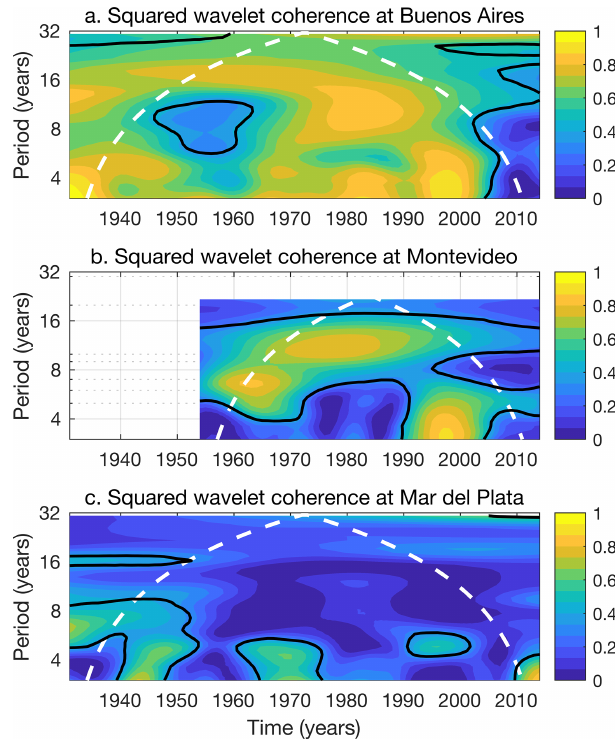
Figure 8. Magnitude-squared wavelet coherence between stream- flow and sea level at (a) Buenos Aires, (b) Montevideo, and (c) Mar del Plata. Solid black lines identify where values are significant at the 68% confidence level, and white dashed lines mark the cone of influence. Statistical significance is determined from 1000 sim- ulations with phase-scrambled versions of the observational data (Theiler et al., 1992). Values are based on the analytic Morlet